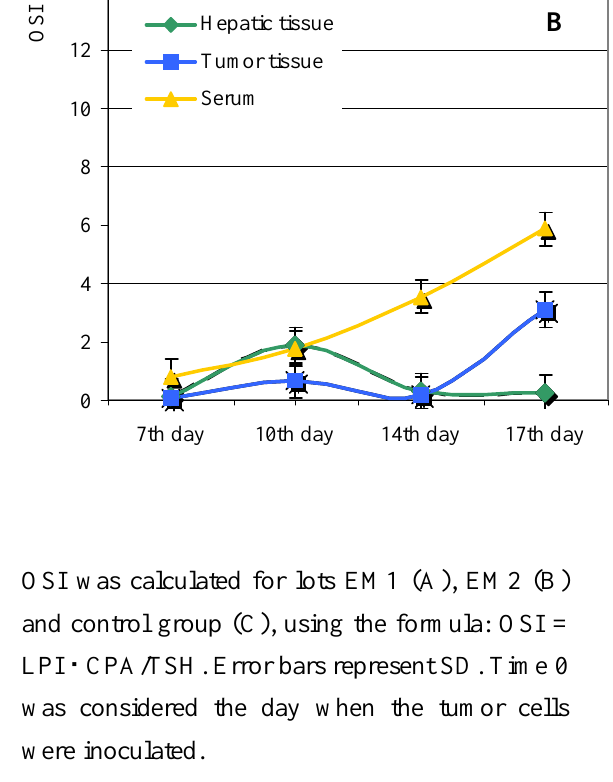
OSI was calculated for lots EM1 (A), EM2 (B) and control group (C), using the formula: OSI = LPI (cid:130) CPA/TSH. Error bars represent SD. Time 0 was considered the day when the tumor cells were